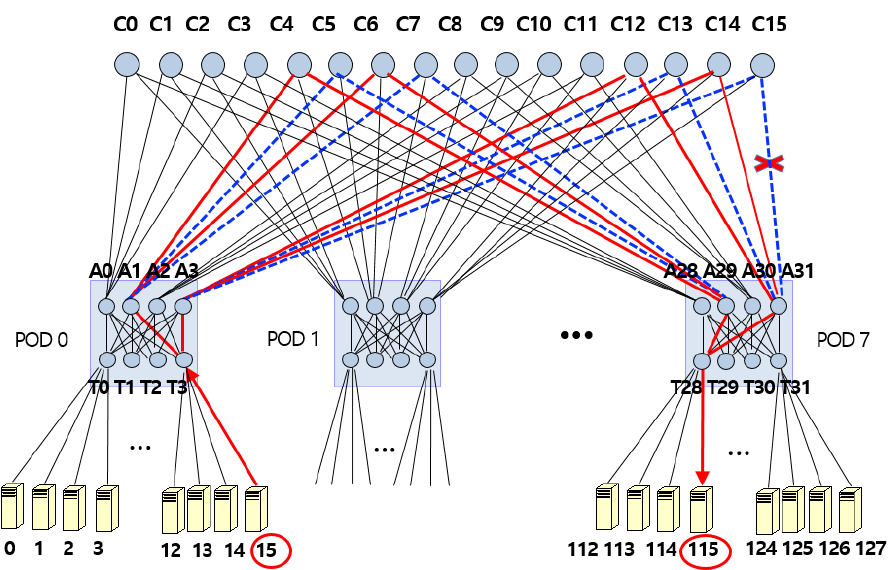
Figure 5. LBSP selects an alternative path group on detecting a failure of the link between core switch C15 and aggregation Switch A31. The red lines indicate the paths that the flow from Host 15 to Host 115 pass through in this case.